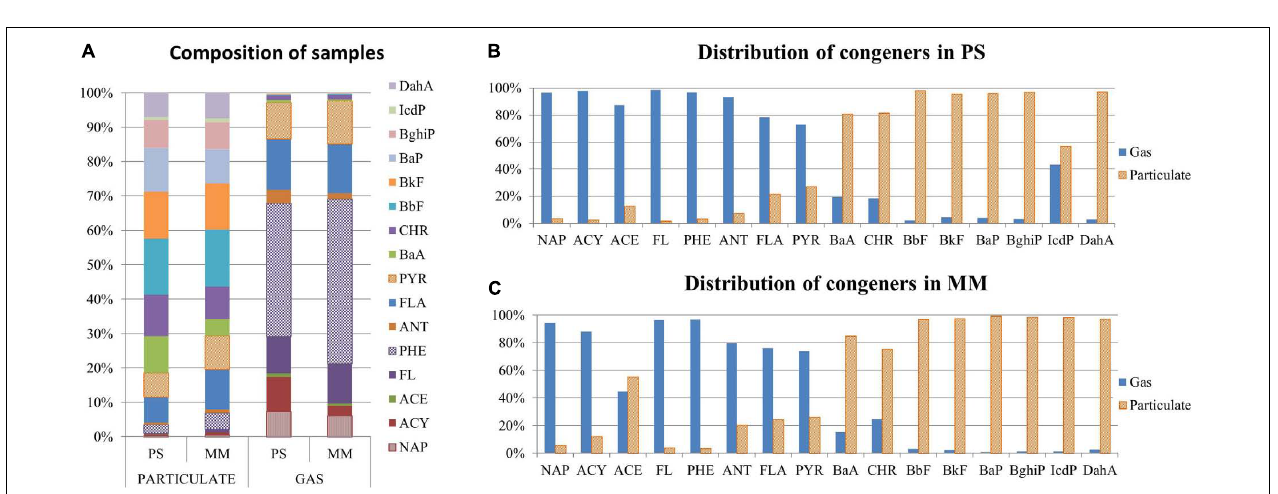
FIGURE 6 | Relative% of PAHs congeners. (A) Composition of gas and particulate samples in PS and MM; relative distribution of congeners among particulate and gas phases in (B) PS and (C) MM.